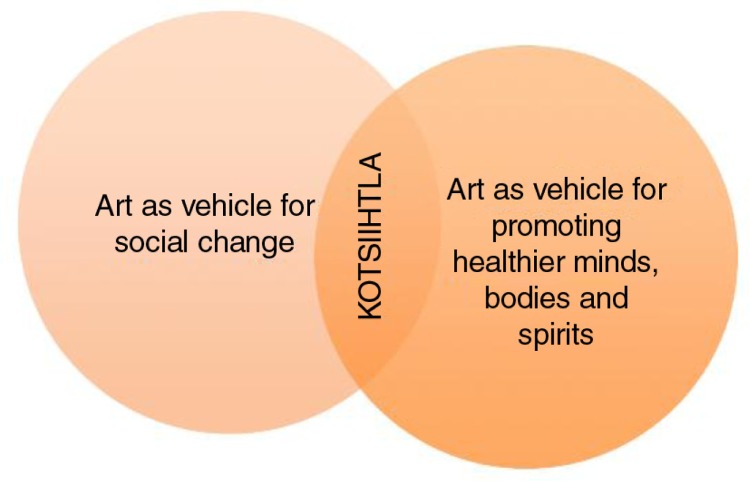
Kts'iìhtła goals.